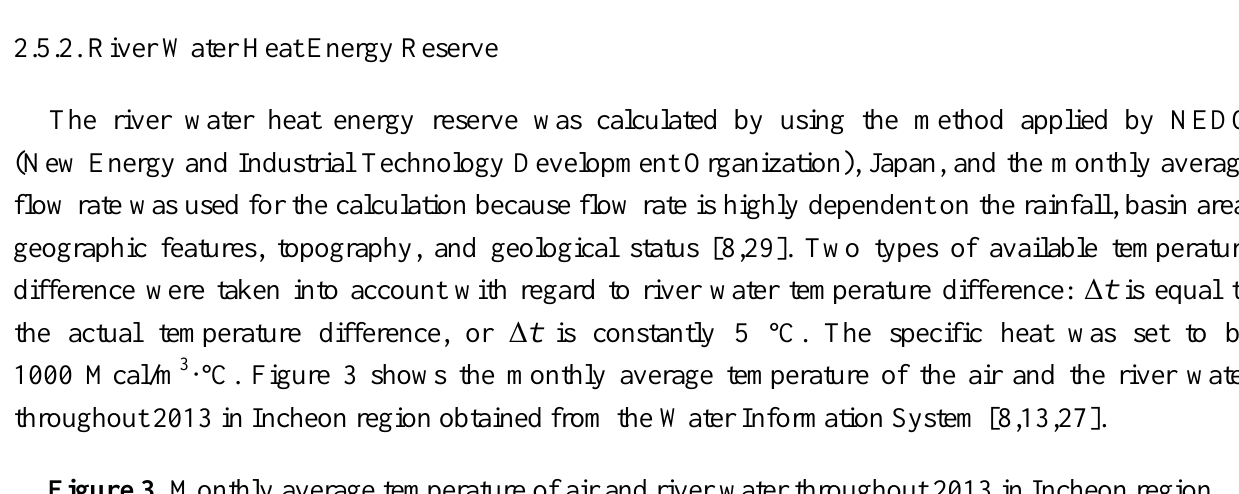
Figure 3. Monthly average temperature of air and river water throughout 2013 in Incheon